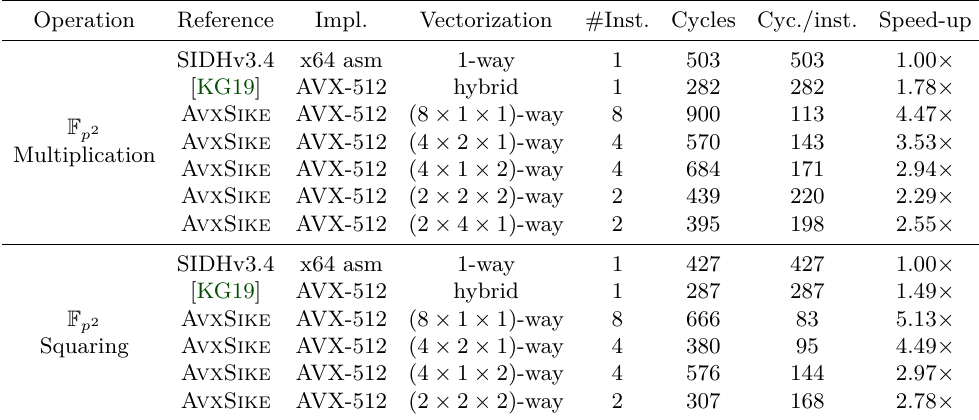
-arithmetic implementations for SIKEp503 p 2